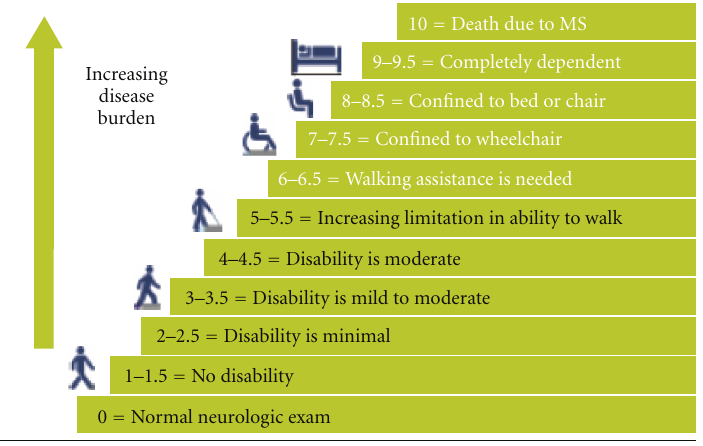
Figure 1: Scaling the progression of disability . EDSS score in MS (published with permission of